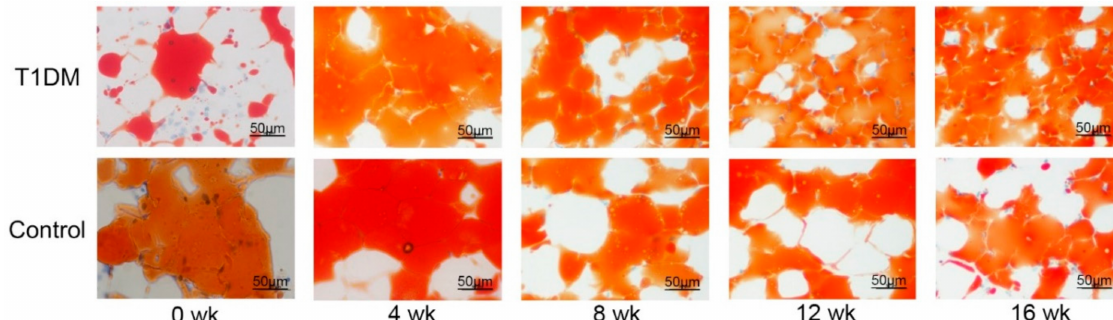
Figure 2. Histological observation of adipose tissues. Epididymal adipose tissues were collected at 0, 4, 8, 12, and 16 weeks after T1DM induction or from normal control rats at the same time points and stained with Oil red O. Magnification = 400 ×